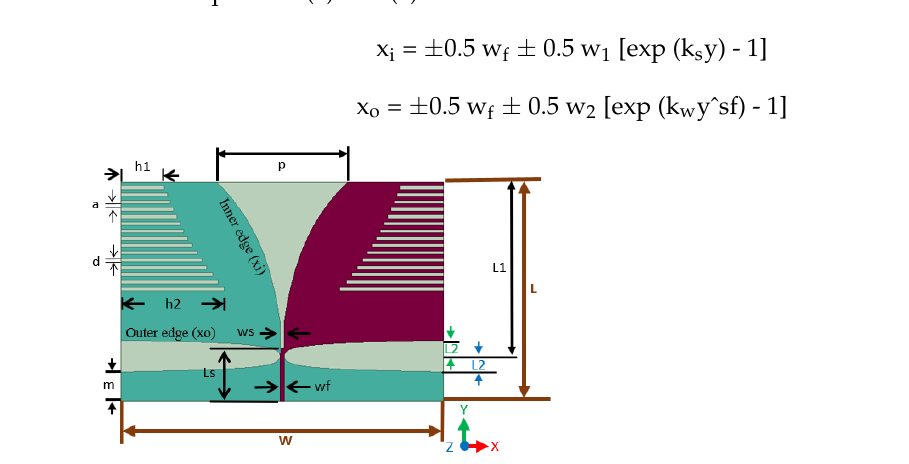
Figure 2. Proposed antenna 1 (top view). Parameters: L = 30.2 mm, W = 44.4 mm, a = d = 0.5 mm, h1 = 6 mm, h2 = 14.27 mm, L1 = 24 mm, L2 = 2.2 mm, p = 18 mm, wf = 0.5 mm, m = 4 mm, ws = 0.5 mm, Ls = 7.2 mm (Reprinted/ adapted with permission from Ref. [35], 2021, IEEE). Here, x i and x o are the distances of the inner and outer edges from the slot center line, respectively. The other parameters are: w 1 = 1.7304 mm, w 2 = 0.18 mm, k w = 2500, sf = 1, and k s = ln((w f + p + w 1 )/w 1 )/L1, where L1 = 24 mm and p = 18 mm. The width of the microstrip-feedline is w f = 0.5 mm, which is connected to the top surface of the antenna. The ground plane is extended along the length by a factor m = 4 mm. The value for ‘m’ is designed by the parametric analysis to obtain good matching and bandwidth performance. The tapered edges of the ground plane feeding are also designed using a similar exponential profile as that in Equation (2), which extends for a length of L2 = 2.2 mm. There are 15 slots in the corrugations of each layer. The slots in the corrugations have a width (a) and separation (d) between two consecutive slots equal to 0.5 mm. The lengths are designed to gradually increase from h1 = 6 mm near the tapered slot opening (p) to h2 = 14.27 mm near the feed region, with a rate of 1/ τ , where τ = 0.94. Additionally, a slot (S) of width ws = 0.5 mm is introduced near the feed at a distance of Ls = 7.2 mm from the port. The width (ws) and position (Ls) of the slot are designed after performing a parametric analysis to obtain better matching performance. The design of the width and the position of the slot (S) require meticulous considerations of both the matching performance and the physical realizability of the antenna. Due to the narrow width of the top copper layer near the feed region, the trace width can become very thin if the slot width (ws) is increased beyond 0.5 mm while placed at a distance of 7.2 mm or less from the port. In order to analyze the effect of increasing the slot width, the position of the slot needs to be moved further away from the port; however, increasing the ws and Ls significantly distorts the exponential profile of the tapered slot near the feed region and can hence adversely impact the performance of the antenna. It has been shown that, for antennas with a shorter height than other major dimensions (length, width), the performance critically depends on the secondary parameters [36]. Therefore, the dimensions of the slots in the corrugation and those of the feed slot play an important role in determining the performance of the antenna. The two half-cut superstrates cover only the copper layers on both the top and bottom radiating surfaces. The length, width, and thickness of each superstrate are L, W/2, and 4h, respectively, where L, W, and h are the length, width, and thickness of the substrate. Finally, no matching/coupling liquid is incorporated to aid in achieving good matching characteristics within the desired frequency range. 3.2. Performance Analysis